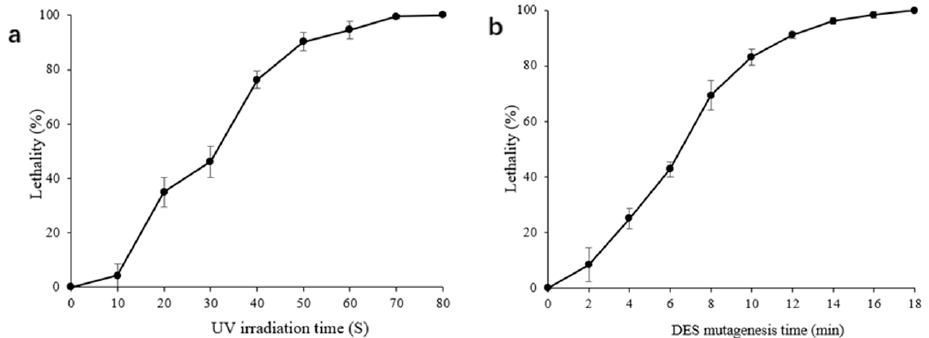
Figure 2. The lethality curve during mutagenesis. ( a ) The lethality curve of strain H5 subjected to UV mutagenesis after exposure to different irradiation times. A UV irradiation time of 40 s was set as the mutation conditions for strain H5; ( b ) the lethality curve of strain H5 subjected to DES mutagenesis after exposure to different times. Treatment with 1% DES for 10 min was set as the mutation conditions for S. cerevisiae . The results expressed as mean ± SD. After treatment with 1% DES for 10 min and UV irradiation for 40 s, 15 mutants (UV1- UV8 and DES1-DES7) displaying a dark red colony color and screened via high-throughput TTC medium were collected. These strains were streaked onto the YPD solid medium containing ethanol to evaluate the ethanol tolerance of the mutant strains. Strain H5 and commercial Saccharomyces cerevisiae S1 were used as controls, and the results are shown in Table 2. The ethanol tolerance of the UV5 and UV8 mutants improved significantly after UV irradiation, increasing to 11% and 10%, respectively. After DES treatment, at the same ethanol concentration (8%), only DES7 exhibited better proliferation than strain H5, while the ethanol tolerance of the other strains did not improve. Table 2. The ethanol tolerance results of mutants H5 and S1 introduced as control strains.